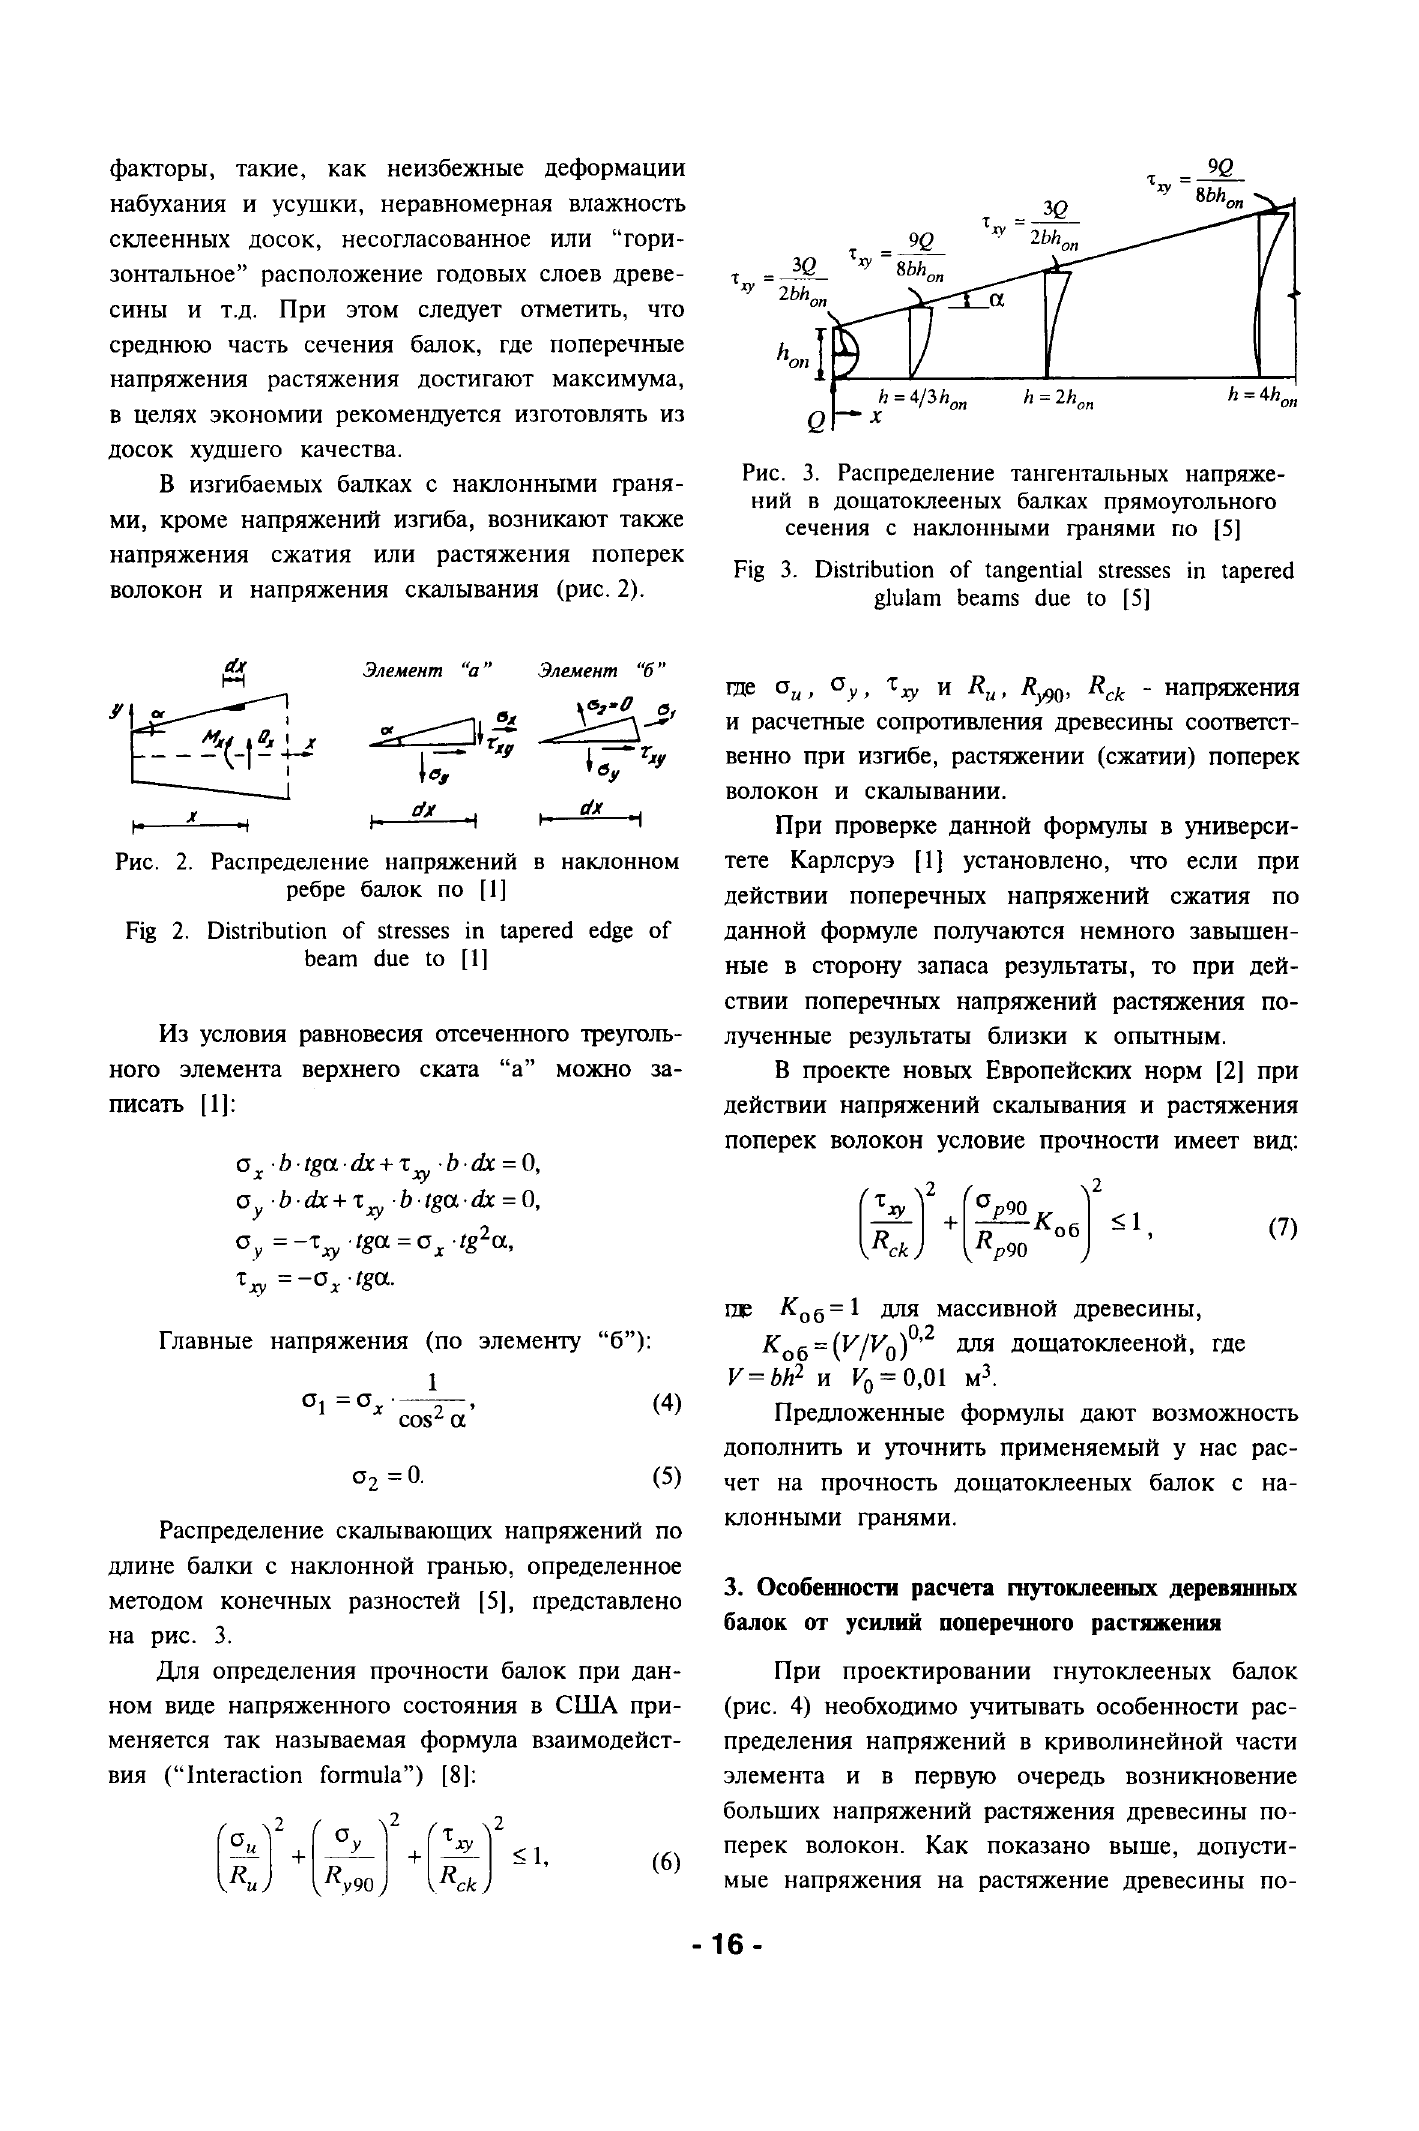
Fig 3. Distribution of tangential stresses in tapered glulam beams due to